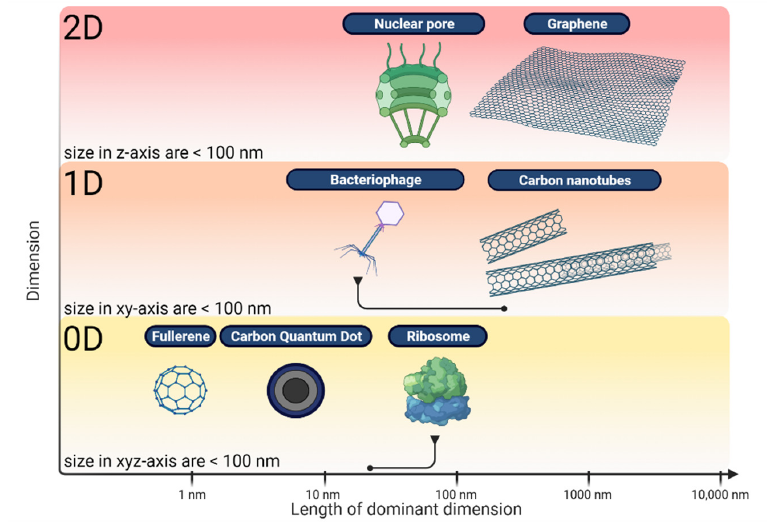
Figure 2. Dimensional classification of carbon nanostructures. The dot-end arrow indicates the precise size on the scale. The location and breadth of other structures indicate the approximate size range. Created with BioRender.com (accessed on 30 December